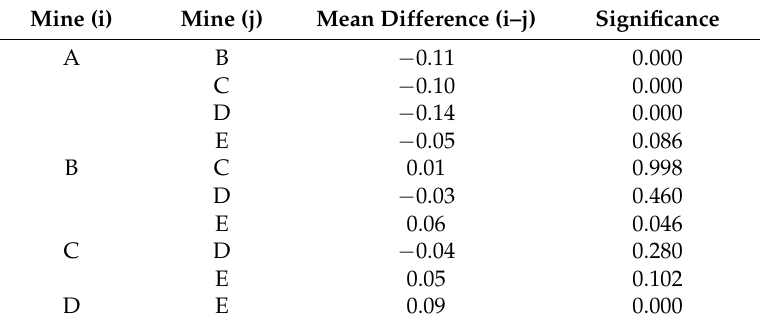
Figure 3. Spider diagram comparing means score of the investigation elements across the mines. Table 5. Post hoc test of incidence rate across the mines (significant at p < 0.05).